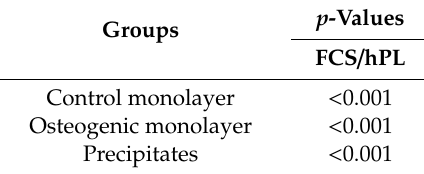
Table 2. Calculation of significant di ff erences of Young’s moduli detected in untreated (control) and osteogenic monolayers and of calcium phosphate precipitates in FCS / hPL groups. p -Values Groups FCS / hPL Control monolayer < 0.001 Osteogenic monolayer < 0.001 Precipitates < 0.001